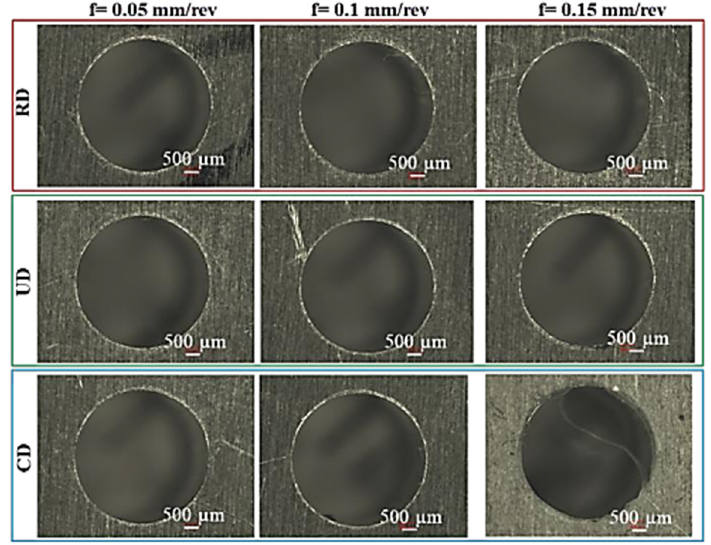
Figure 10. Entry delamination on the aluminum sheet at varying feed and drilling strategies [73].